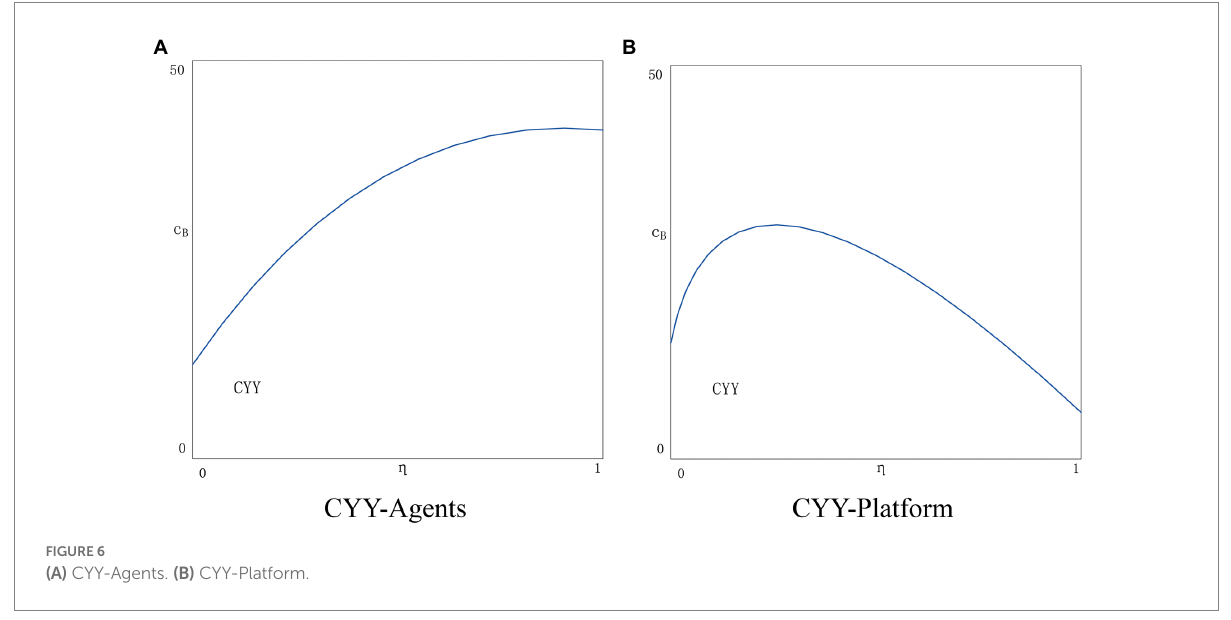
FIGURE 6 (A) CYY-Agents. (B)